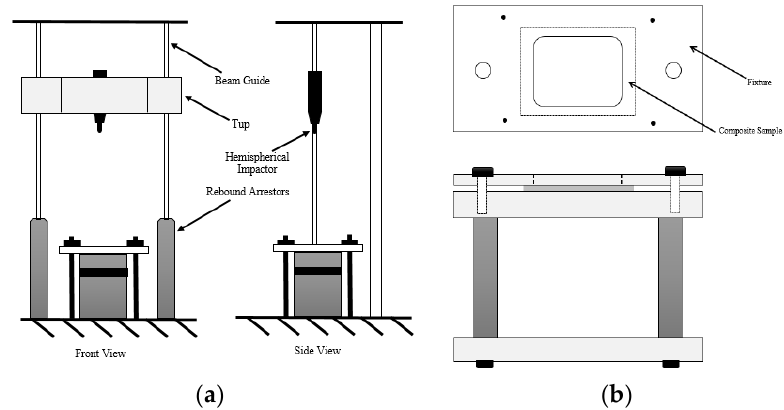
Figure 2. Schematic of ( a ) drop-weight test, and ( b ) fixture and sample location.